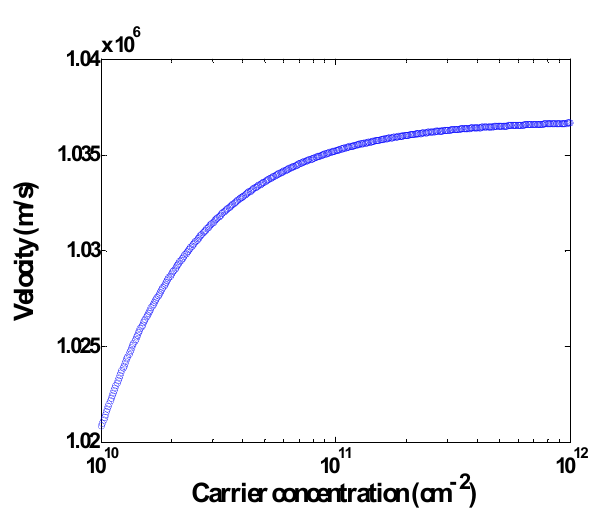
Figure 7. Carrier velocity of the graphene against the carrier concentration.